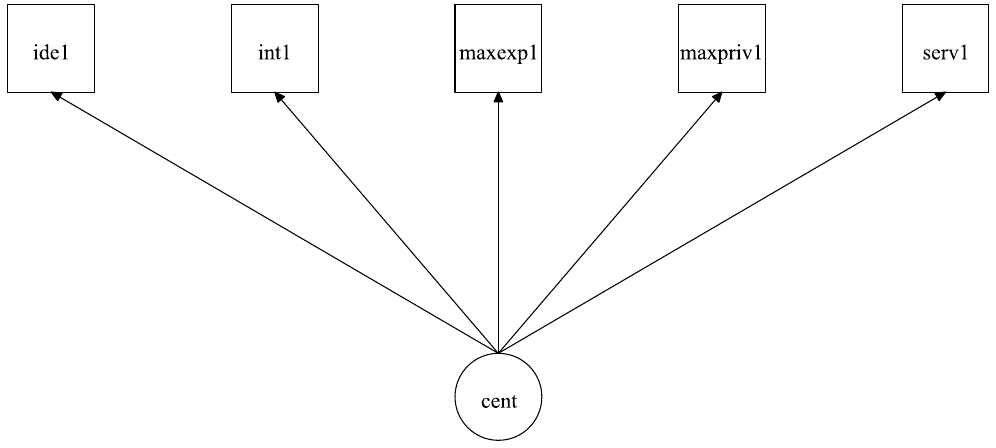
Figure 2. The confirmatory factor analysis model for the CRSi-7. int = intellect; ide = ideology; serv = public practice; priv = private practice; exp = experience; max = this prefix means that out of two items, only the one with the higher value for this core dimension is proceeded in the analysis. The number after the item name indicates the position of the item within the core dimension items. Squares depict manifest and circles latent variables. Residual arrows are not shown for the manifest variables.